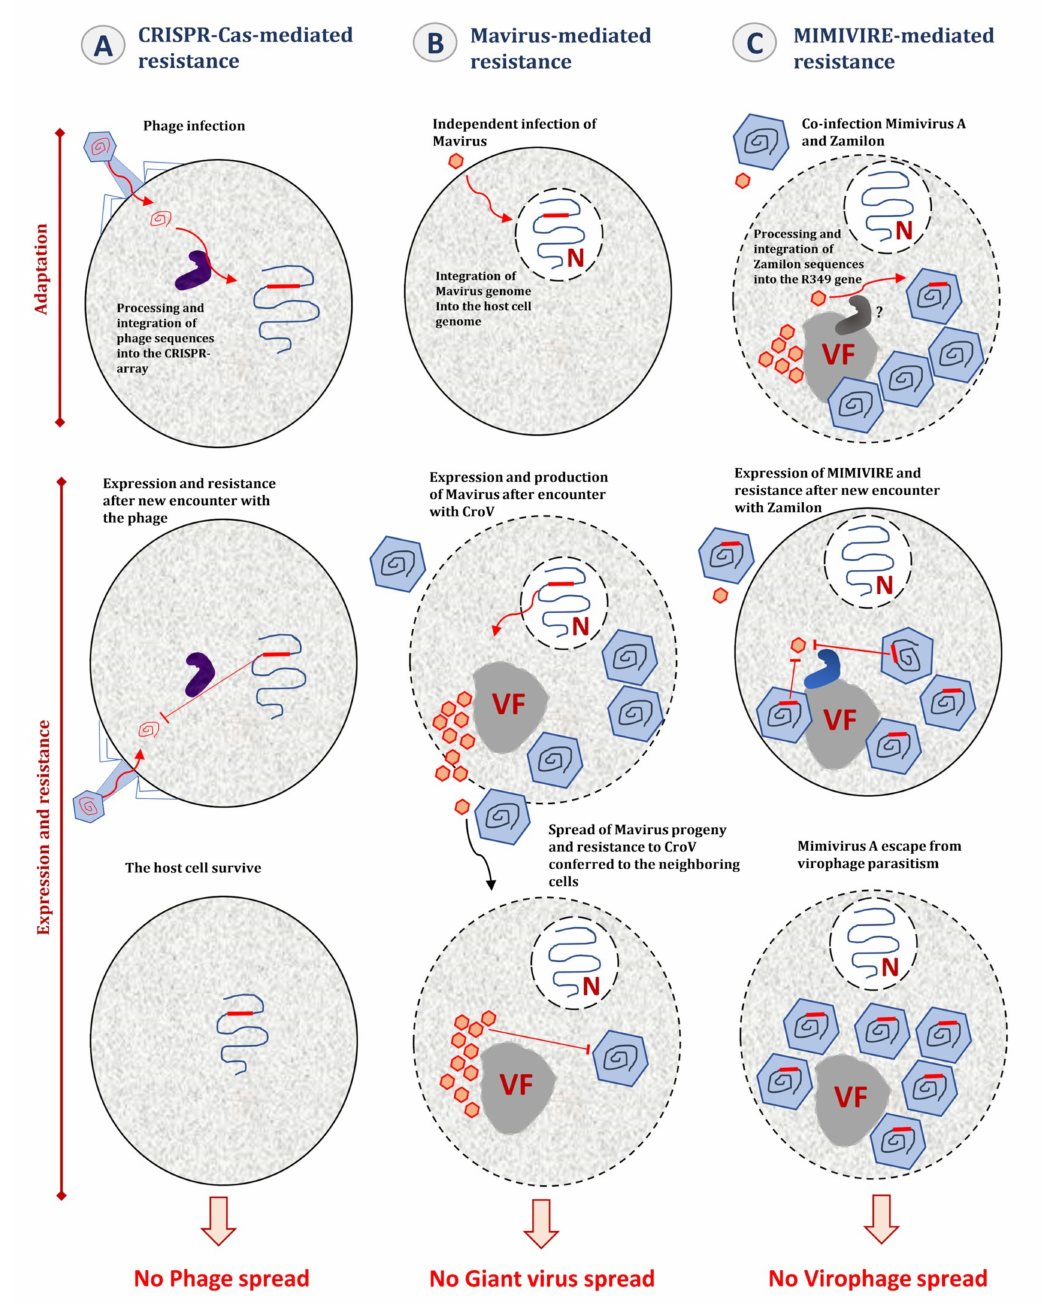
Figure 5. Analogies between the CRISPR-Cas-, the Mavirus- immunity, and the MIMIVIRE-mediated immunity systems. All these mechanisms seem to implicate a record of genetic sequences and their integration into the genome of immunized organisms at their first step (adaptation). ( A ) For the CRISPR-Cas system, the host cell incorporates DNA pieces from the invading phage (proto-spacers) into the CRISPR arrays (spacers) (not represented here). This mechanism is mediated by the Cas machinery (in purple). ( B ) After an independent entry of Mavirus in the host cell, the virophage integrates its genome into the host genome and becomes latent. This mechanism seems to involve Mavirus-encoded retroviral integrase. ( C ) Mimiviruses from lineage A have integrated DNA sequences from Zamilon into their R349 genes. However, unlike the CRISPR-Cas and Mavirus systems, the integration mechanism of Zamilon DNA has not been characterized. The next step of the resistance mechanism is marked by the expression of the integrated genetic pieces. (A) For the CRISPR-Cas system, transcripts of the